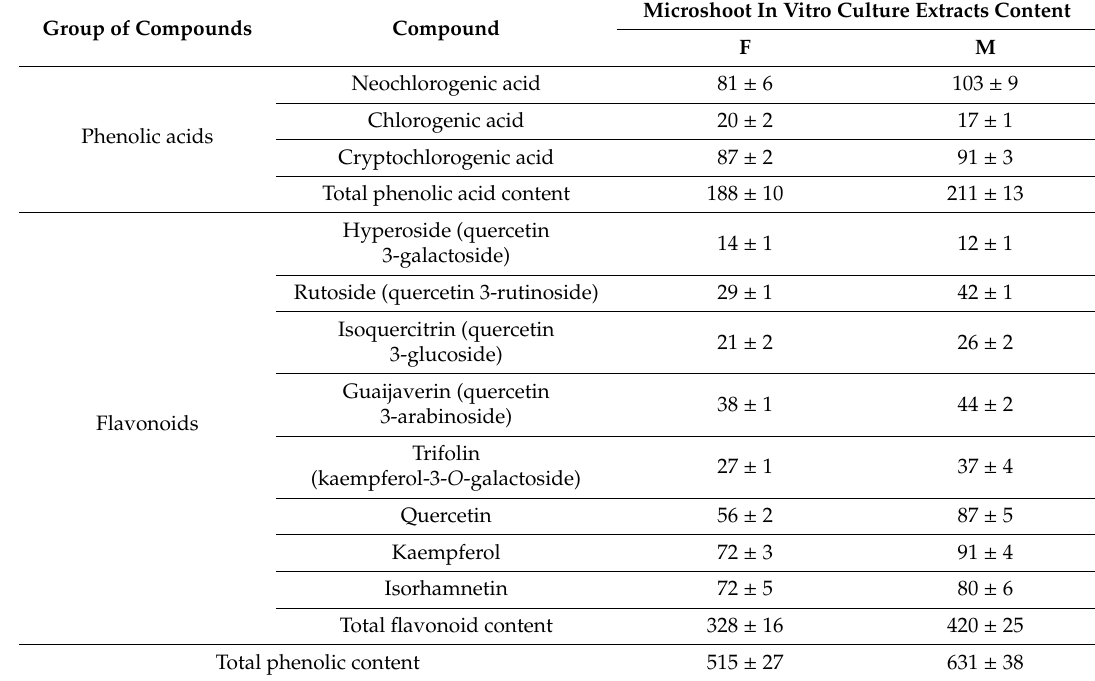
Table 5. The content (mg / 100 g DW ± SD) of main detected phenolic compounds of S.